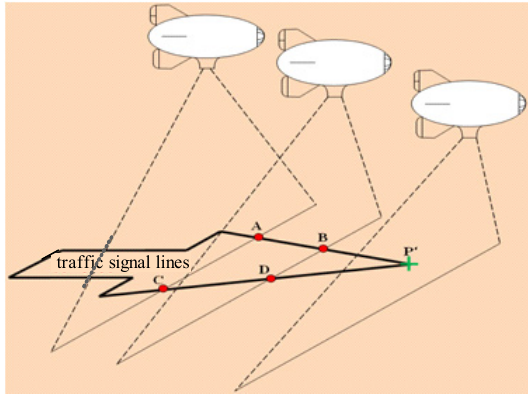
Figure 10. ( a ) The original hyperspectral pushbroom images from “LanTianHao” HAA; and ( b ) the rectified image by SS-7. Figure 11. Computing coordinates of checkpoints using ground traffic signs.